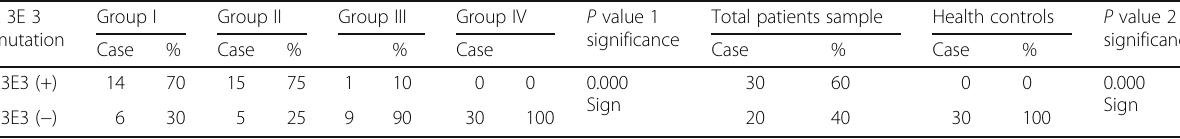
Table 9 Frequency distribution for the presence and absence of E3E3 polymorphism E 3E 3